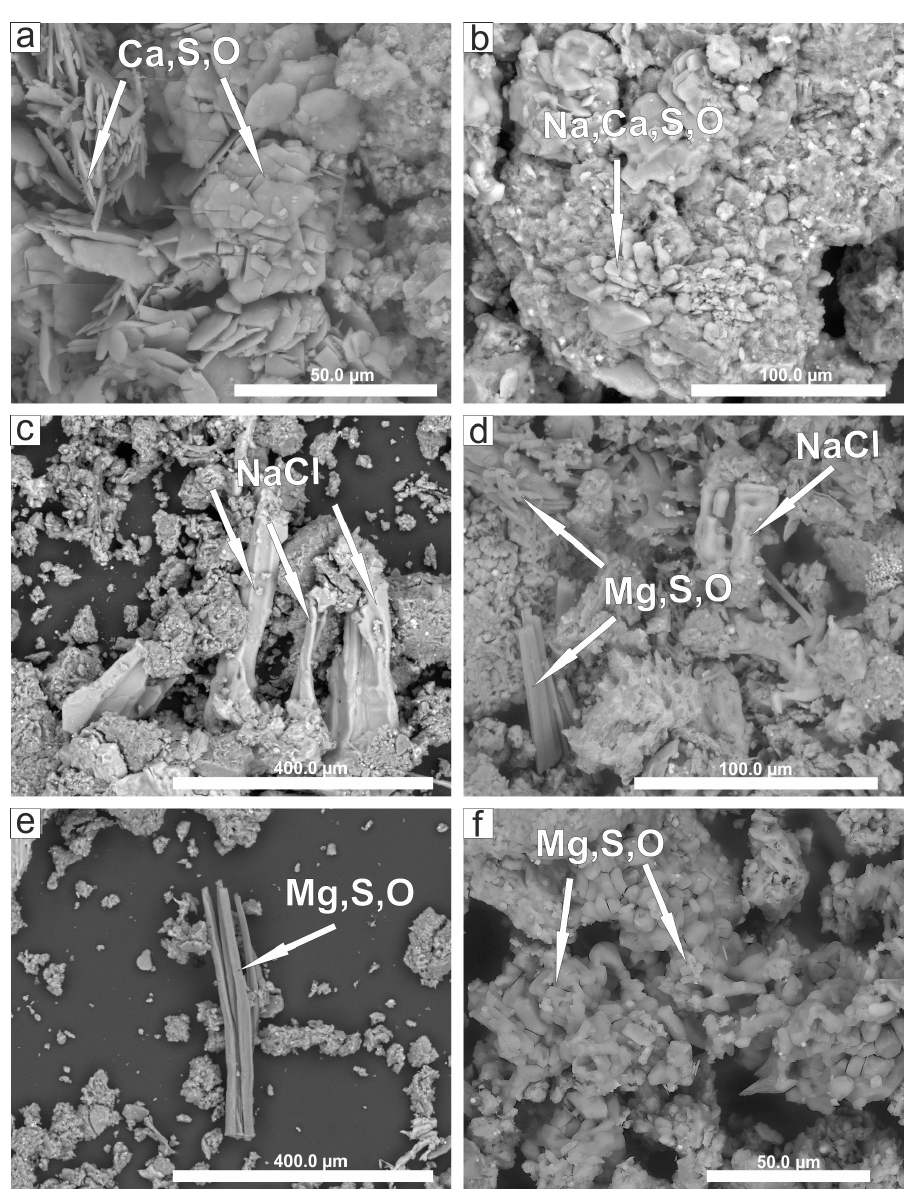
Figure 6. SEM images of individual airborne particles settled in the entrance zone. ( a ) Agglomerate of Ca-sulfates, E.2; ( b ) agglomerate of Na and Ca sulfates E.2; ( c ) NaCl particles, E.4; ( d–f ) various morphology of Mg-sulfate, E.3.